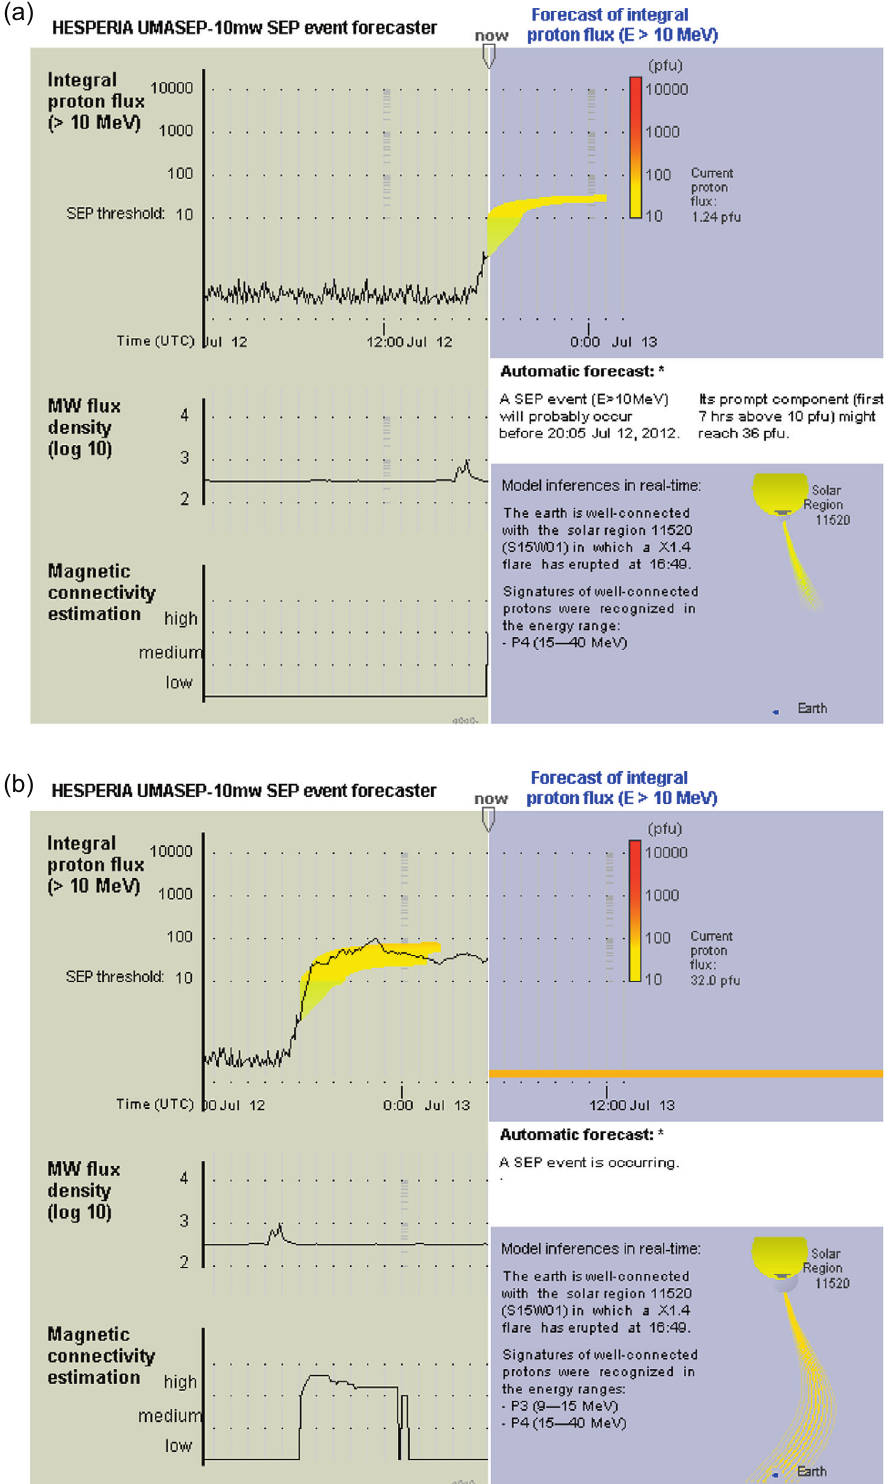
Fig. 5. Two UMASEP-10mw outputs after processing microwave data at 5 GHz from 2012 July 12 and GOES proton fluxes of >10 MeV energies. (a) The prediction at 18:05. (b) The subsequent evolution of the >10 MeV integral proton flux. The yellow/orange band in the proton intensity plots gives the predicted range, with the colour scale shown by the vertical